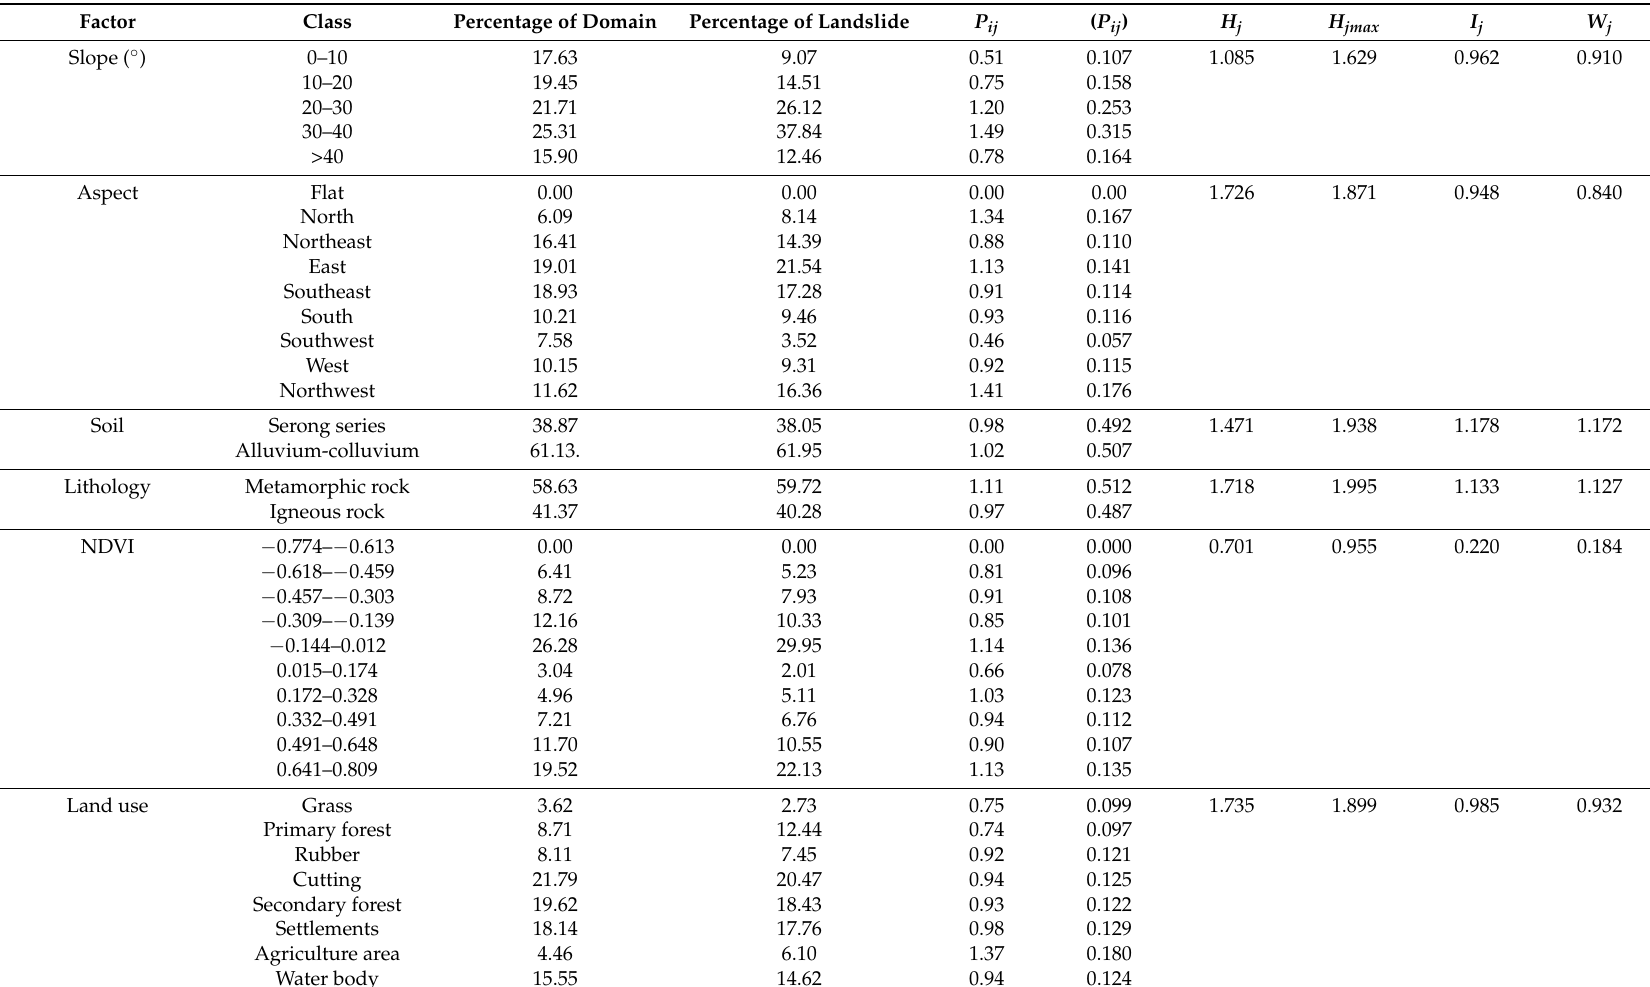
Table 5. Spatial relationship between each landslide conditioning factor and landslide by the SVM and IOE